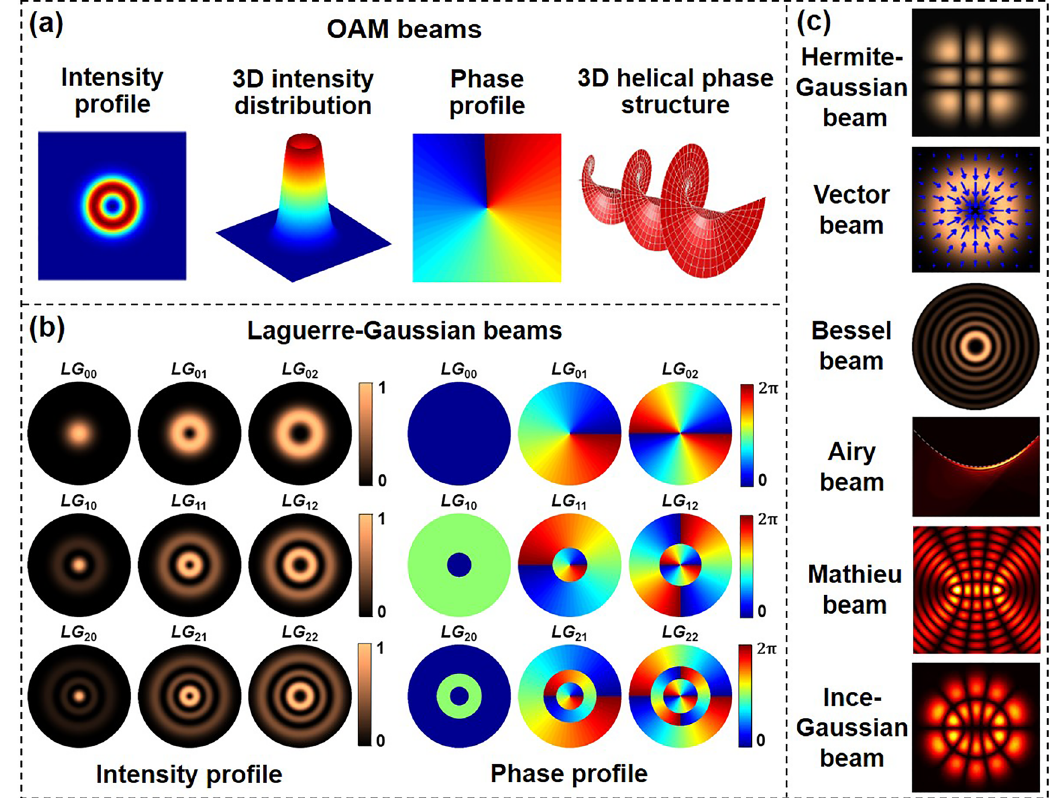
Figure 1: Different types of structured light beams. (a) Intensity profile, 3D intensity distribution, phase profile, 3D helical phase profile of OAM beams; (b) intensity and phase pro fi les of Laguerre – Gaussian (LG) beams; and (c) other structured light beams: Hermite – Gaussian (HG) beam, vector beam, Bessel beam, Airy beam, Mathieu beam, Ince – Gaussian